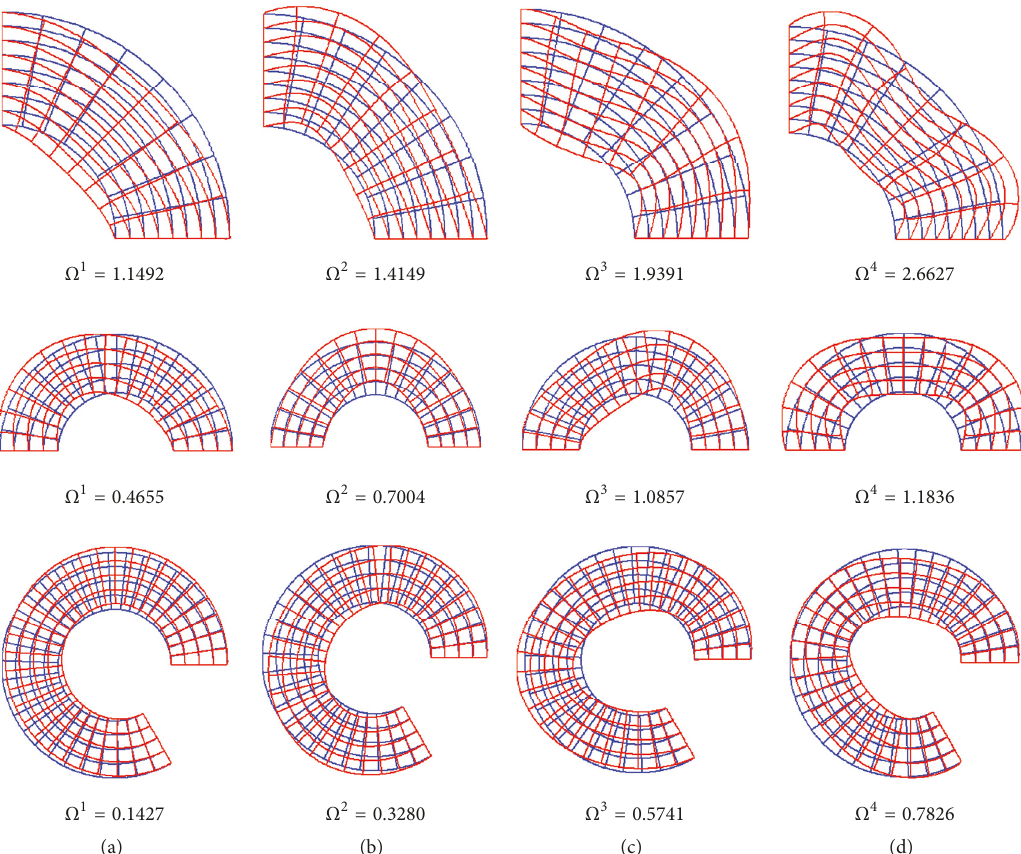
Figure 7: The first four mode shapes of FCFC annular sector plate ( 𝑅 0 /𝑅 1 = 0.5 ) with different sector angles, that is, 𝜙 = 90 ∘ , 180 ∘ , and 300 ∘